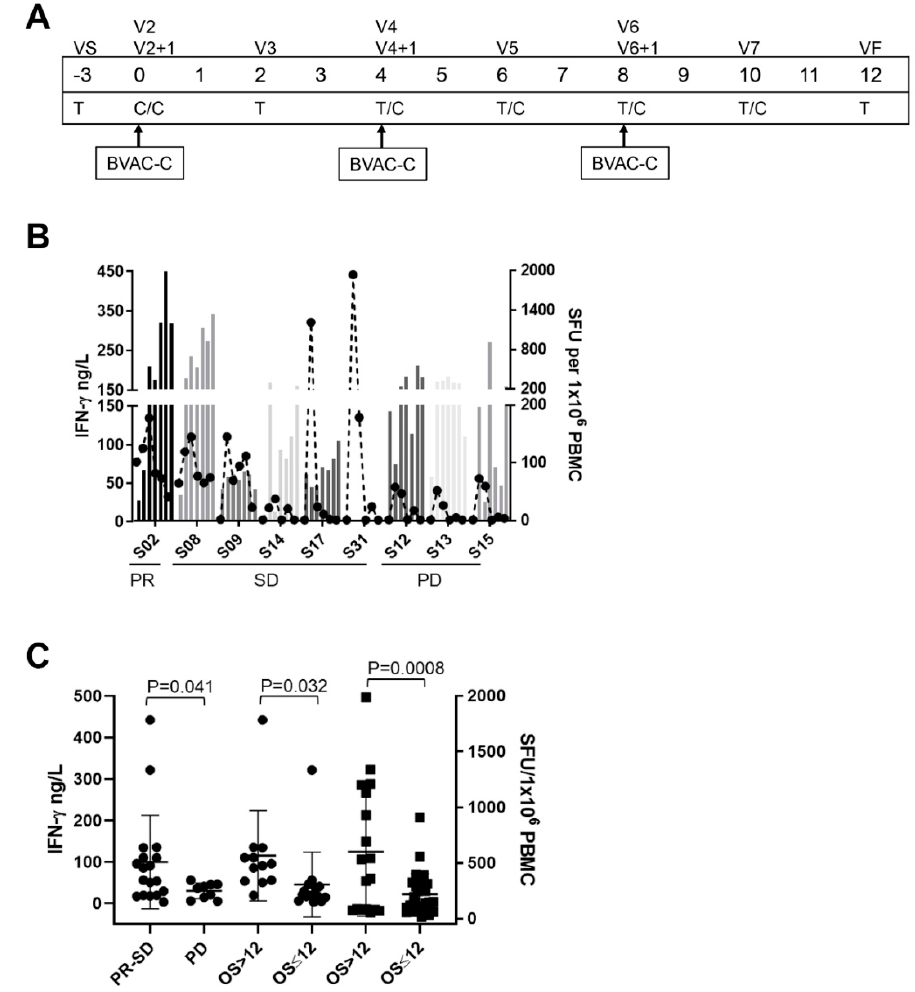
Figure 2. Study schedule and immune response assessment result. ( A ) Study timeline indicating BVAC-C administration and an immune response assessment schedule. T is for T cell Elispot assay, and C is for cytokine measurement. ( B ) Serum IFN- γ levels at each time-points, black circle with a dashed line, and HPV-specific T cell spots at each time-points, grey bars. ( C ) Serum IFN- γ concentrations one day after each BVAC-C administrations are plotted in four groups (circles), and HPV-specific T cell spots of all time-points are plotted in two groups (squares).